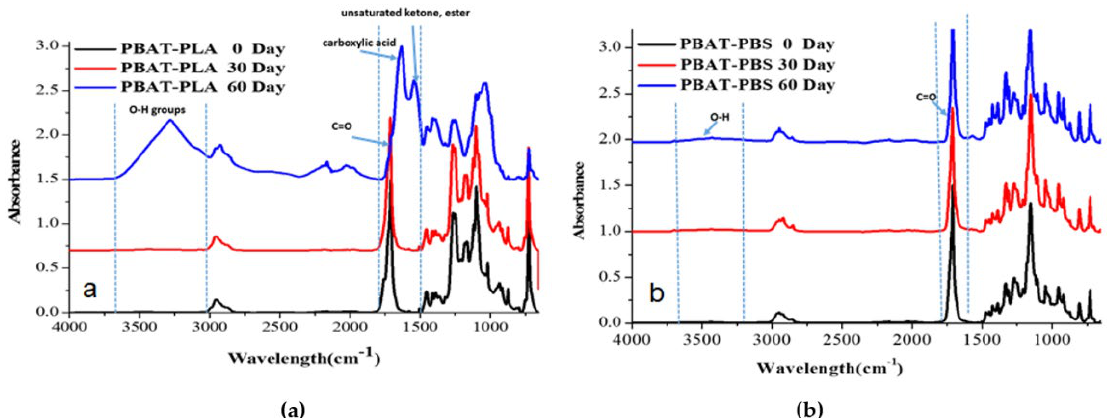
Figure 2. ( a ) The IR spectra of PBAT–PLA at 0 day, 30 days and 60 days after degradation, and ( b ) the IR spectra of PBAT–PBS at 0 day, 30 days and 60 days after